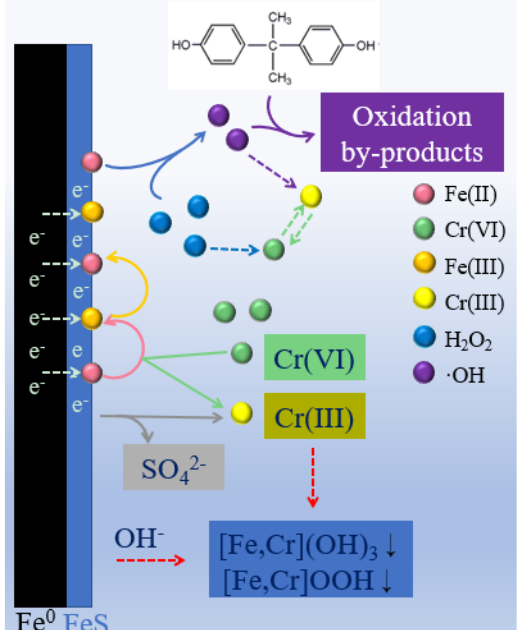
Figure 5. Schematic illustration of synchronous removal of BPA and Cr(VI) in the S ‐ nZVI/H 2 O 2